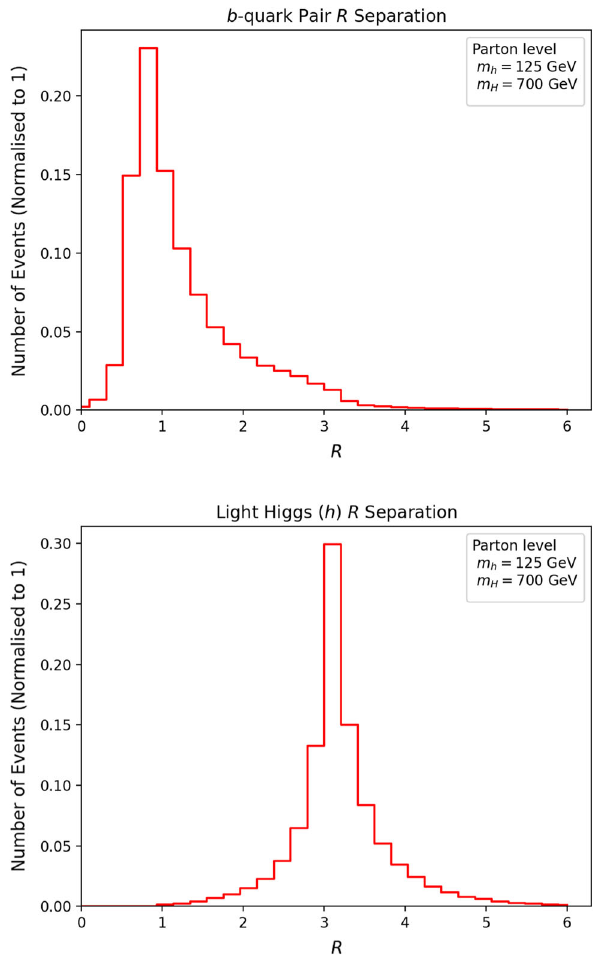
Fig. 4 Upper panel: (cid:6) R separation of the b ¯ b pair from a given Higgs. Lower panel: (cid:6) R separation between the two Higgses